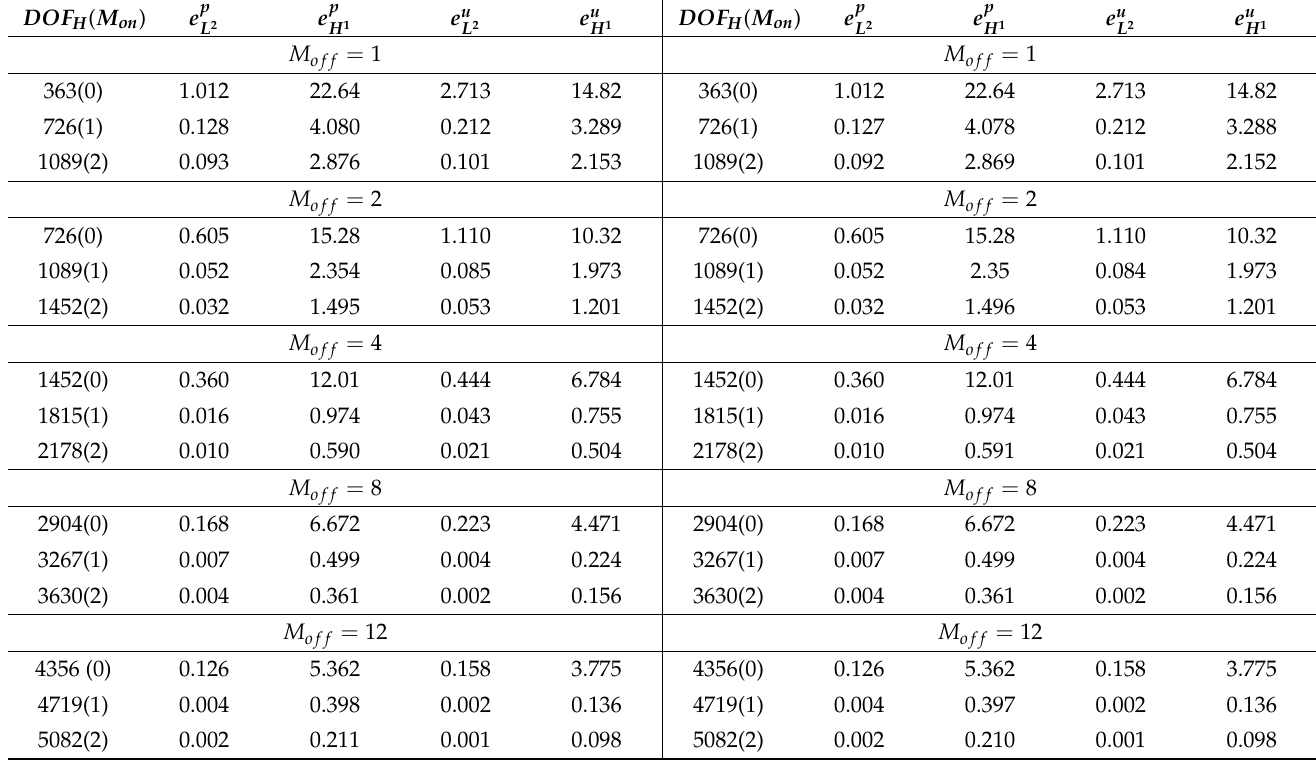
Table 1. Case 1 . Relative errors for displacement and pressures with a different number of offline and online basis functions ( M of f and M on ). Online basis functions are updated every 5 and 10 time steps (left and right, respectively).